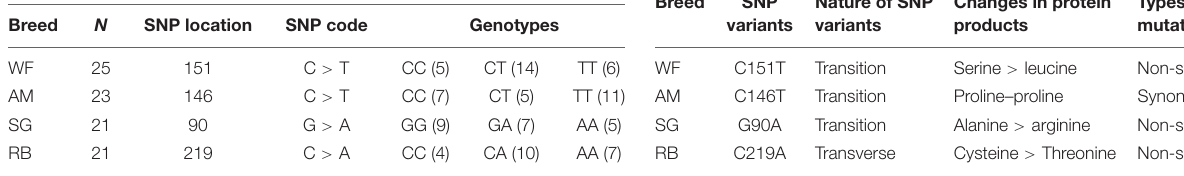
( Hoek et al., 2008), and human genetic variants linked to cancer (Krypuy et al., 2007).